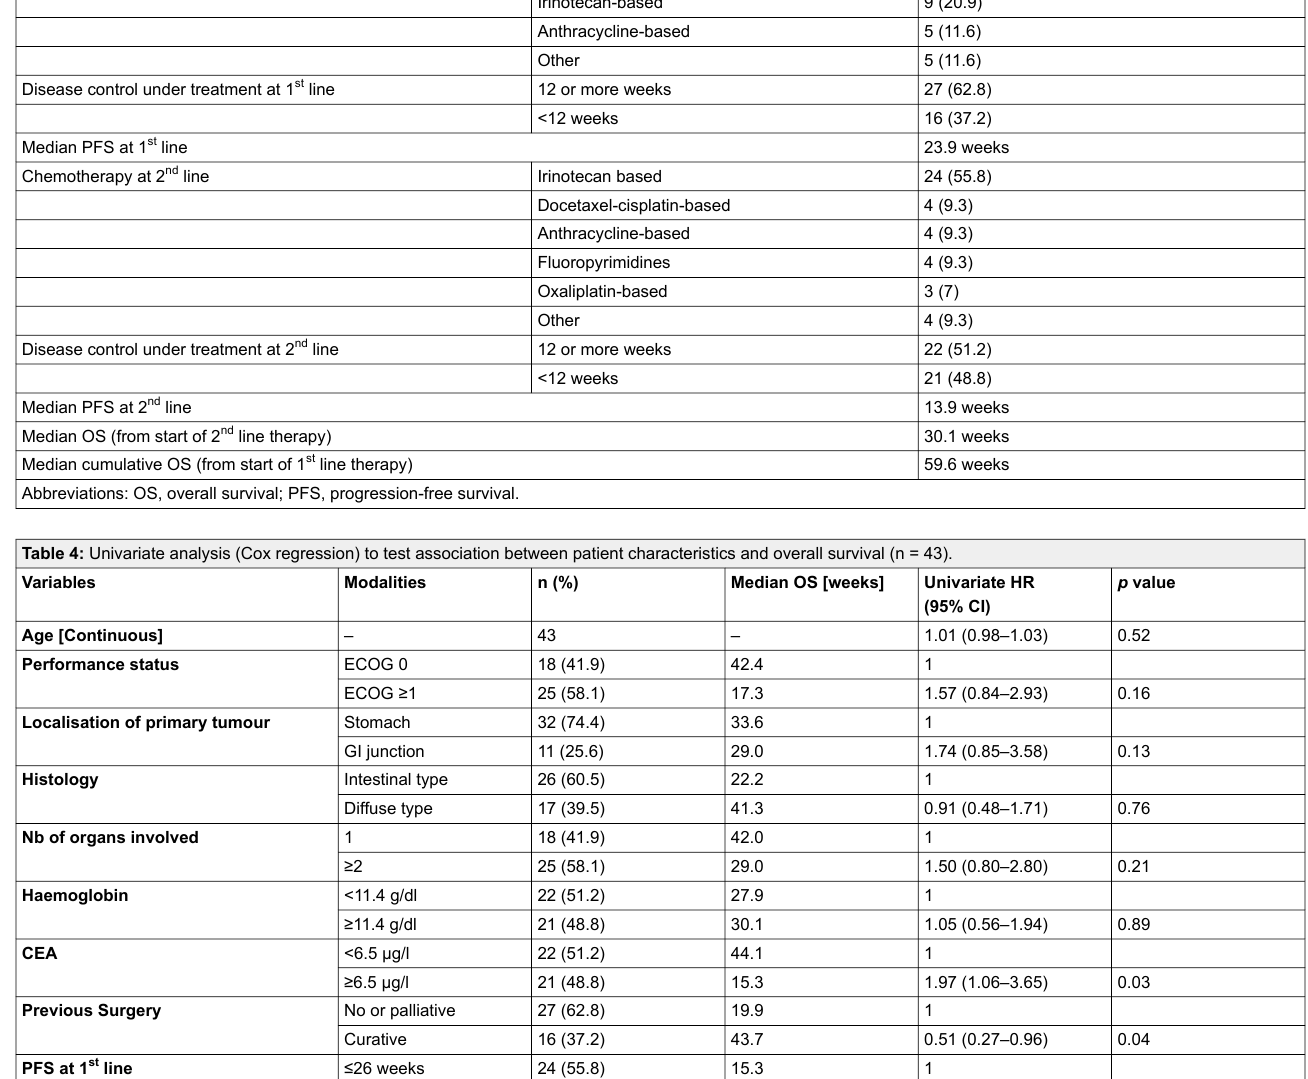
Disease control under treatment at 1 st line Median PFS at 1 st line